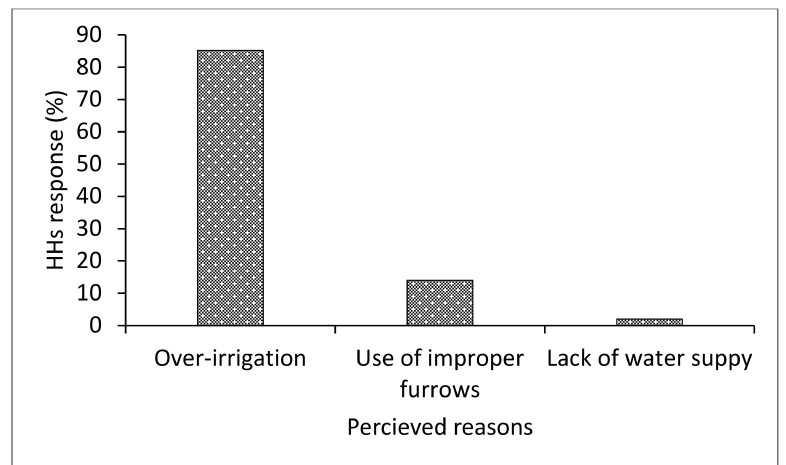
Figure 8. Perceived reasons for water scarcity in the Koga irrigation